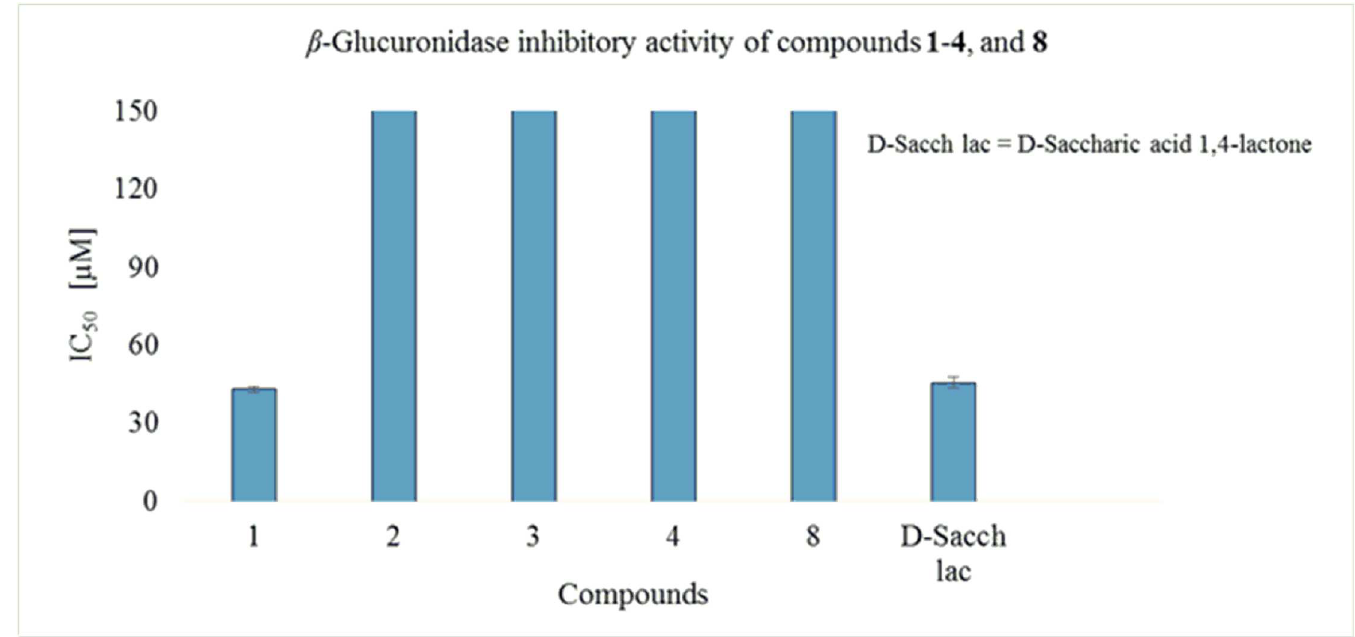
Fig 9. β -Glucuronidase activity of compounds were shown in graphical representation.